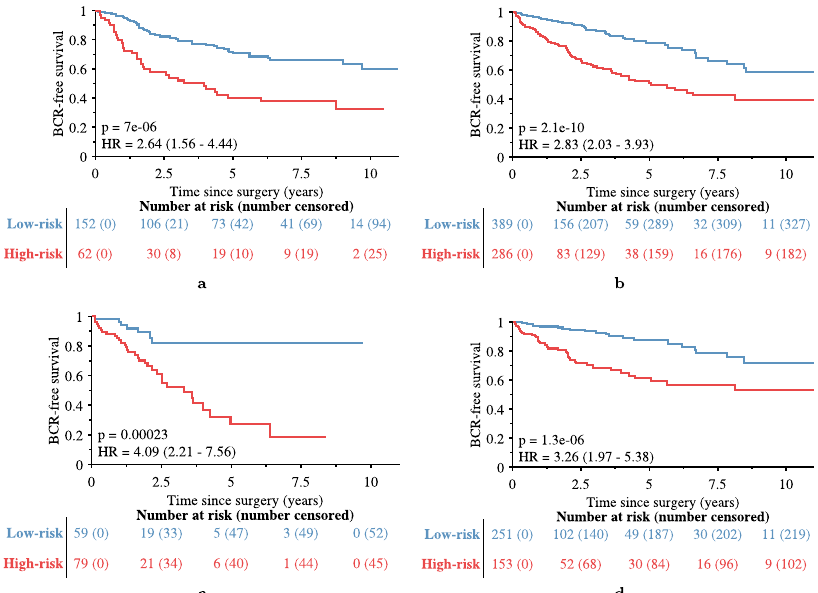
Fig. 4 Kaplan-Meier BCR-free survival plots of patients in the training and validation sets. Patients are categorized as (blue) Histotyping low-risk and (red) Histotyping high-risk. Shown are ( a ) the n = 214 patient training set, b the n = 675 patient validation set, ( c ) the n = 138 patients of the validation set with Gleason grade group of 3, and ( d ) the n = 404 patients of the validation set with negative surgical